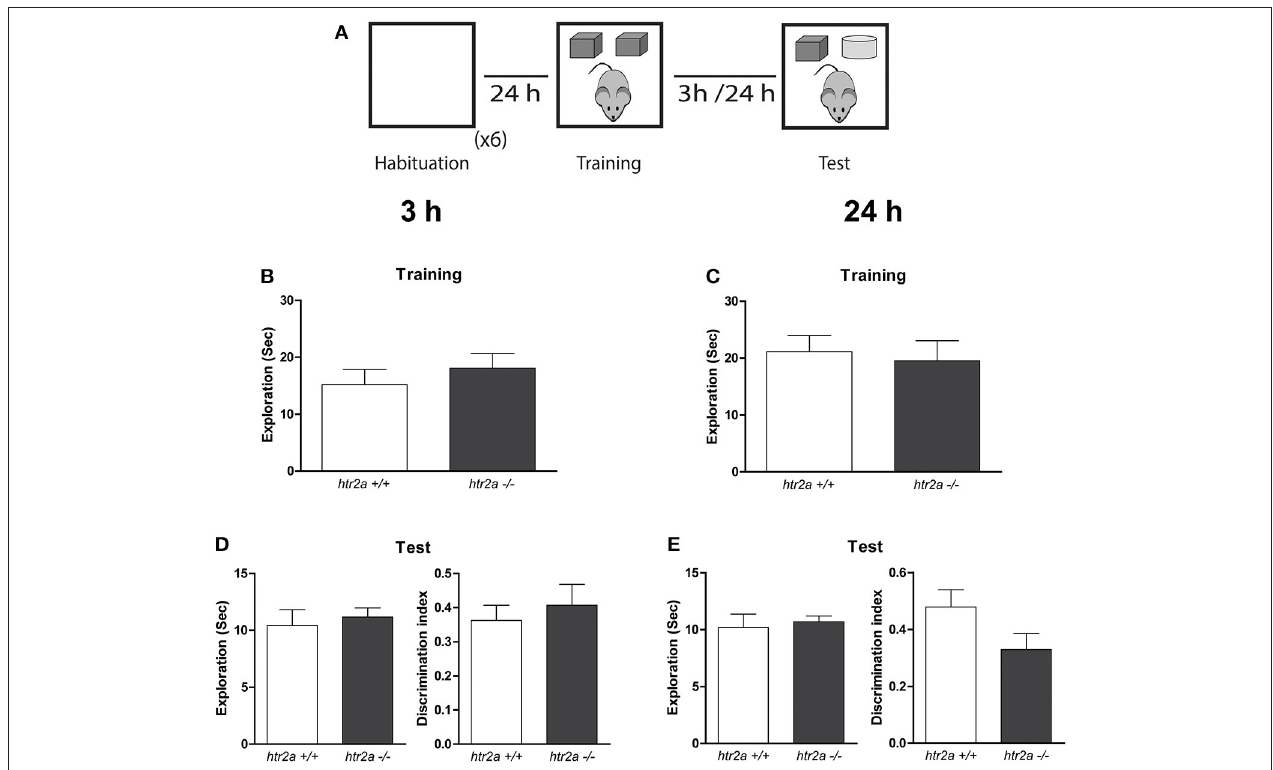
FIGURE 1 | 5-HT2aR is not required for the single-item object recognition. (A) Training and Testing scheme. The mice were exposed to a context containing two identical copies of an object for 10min. Three or twenty-four hours later they were re-exposed for 5min to the same context of the training phases containing one copy of the objects previously presented and a copy of a new object. (B,C) Exploration time measured in seconds made by the mice during the training. (D,E) Total exploration measured in seconds (left) and Discrimination index (right) obtained from the test phase delayed 3 or 24h from the training phase. DI was calculated as the time spent exploring the novel object minus the time spent exploring the familiar object over the total exploration time. n = 9 –11 per group, p > 0.05 , Student’s t